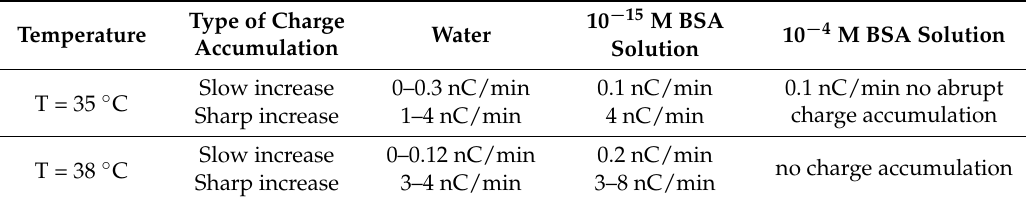
Table 1. Dynamics of charge accumulation in the measuring cell upon permanent drop-wise influx of water or protein solution out of the AFM-fishing system injector